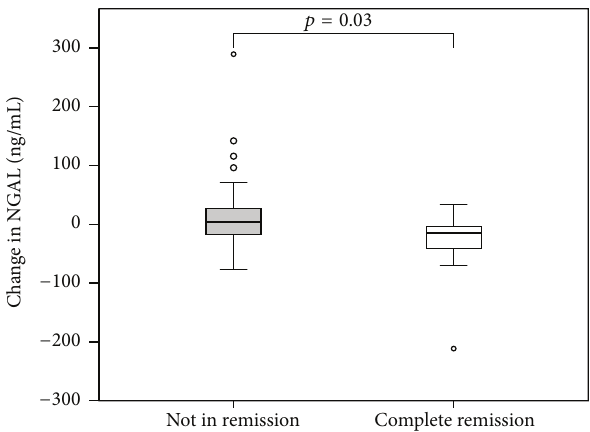
Figure 4: Change in NGAL (ng/mL) levels according to remission status at follow-up. Change in urine NGAL levels from baseline to follow-up between complete remission ( 𝑛 = 10 ) versus not in remission ( 𝑛 = 33